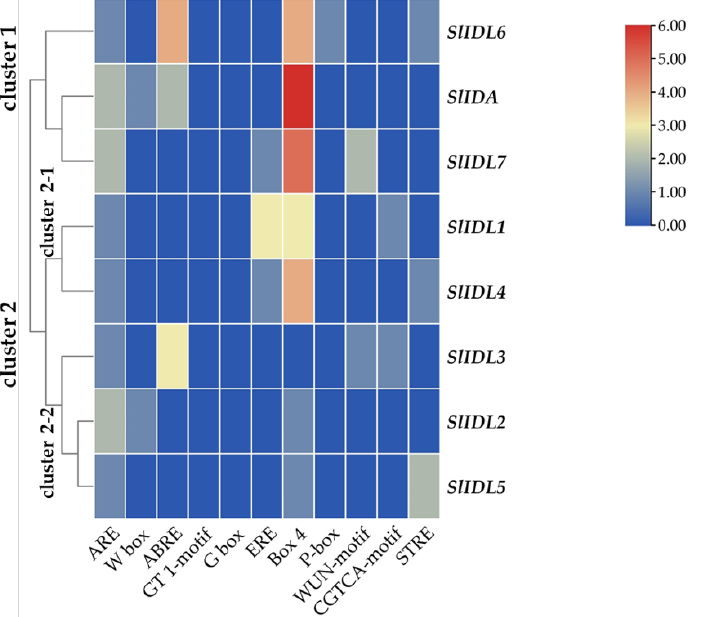
Figure 5. Cisregulatory elements in the promoter regions of SlIDA genes. ARE (anaerobic induction element), W-box (WRKY binding site), ABRE (cisacting element involved in the abscisic acid responsiveness), GT1-motif (light responsive element), G Box (cisacting regulatory element involved in light responsiveness), ERE (ethylene-responsive cisacting regulatory element), Box 4 (part of a conserved DNA module involved in light responsiveness), P-box (gibberellin-responsive element), WUN-motif (wound-responsive element), CGTCA-motif (cisacting regulatory element involved in the MeJA-responsiveness), and STRE (stress response element) are identified in the promoters of eight SlIDA genes. Heatmap clustering for cisregulatory elements of SlIDA genes was generated with the Euclidean distance measurement and complete cluster method. Scale bars on the right indicate the relative enrichment for the identified cisregulatory elements.